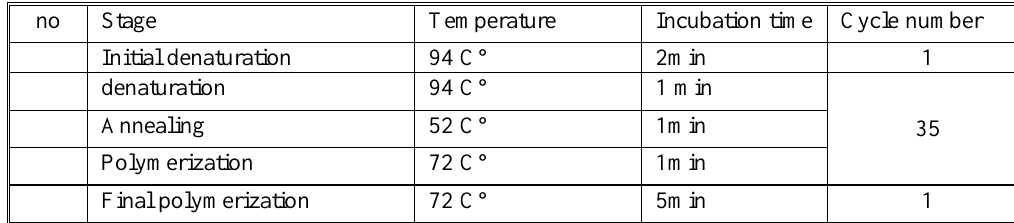
Table 2.The PCR mixture thermocycling